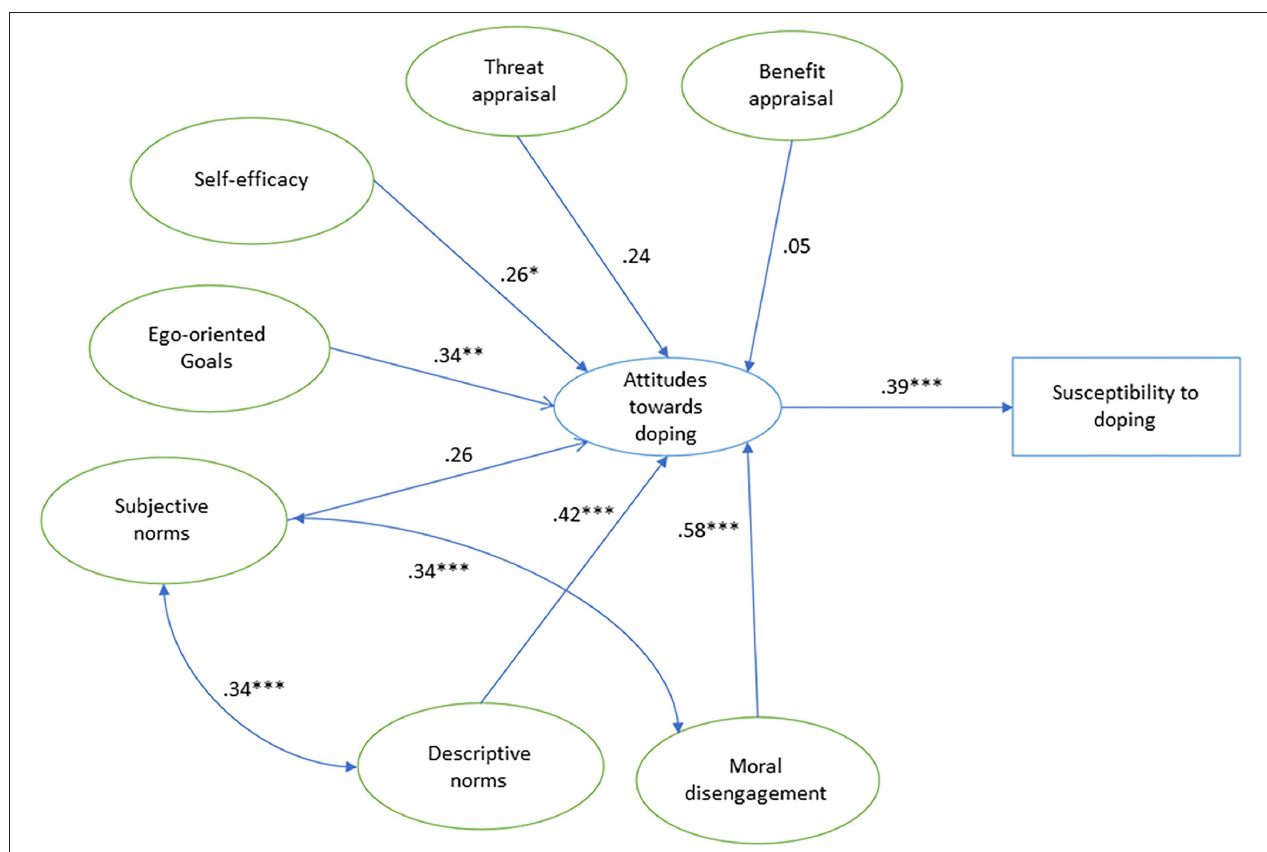
FIGURE 1 | Overview of results of structural equation model analysis with standardized parameter estimates. Different levels of significance according to p -value: * p ≤ 0.05, ** p ≤ 0.01, and *** p ≤